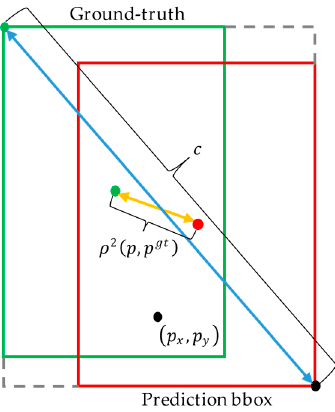
Figure 3. The rhombus classification labels and four sides regression of bounding box.